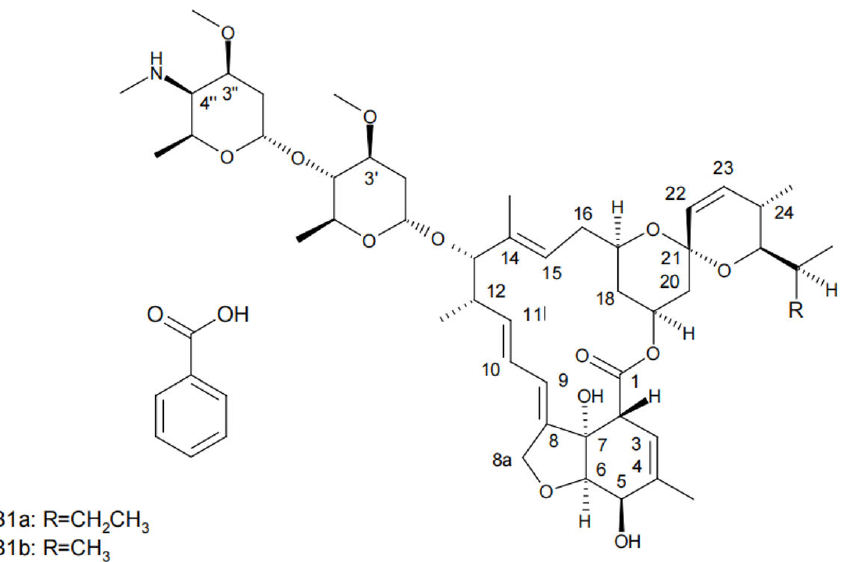
Figure 1. Chemical structures of emamectin benzoate (R = CH 2 CH 3 for emamectin B1a benzoate; R = CH 3 for emamectin B1b